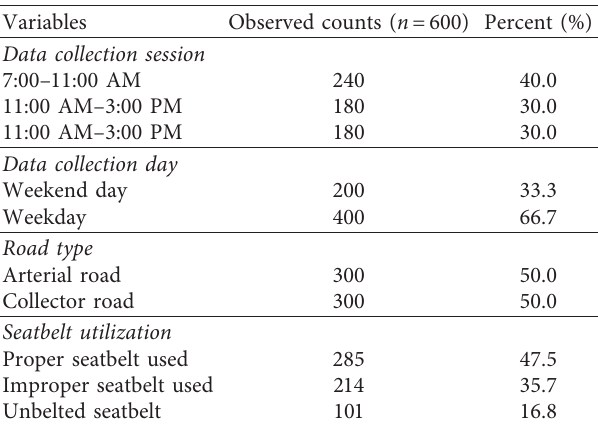
Table 2: Distribution of seatbelt use among public transport drivers in Addis Ababa, Ethiopia,